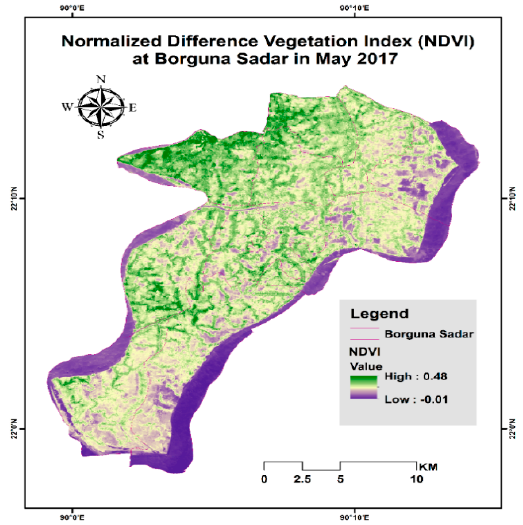
Figure 5 . Normalized Difference Vegetation Index (NDVI) map . Figure 5. Normalized Difference Vegetation Index (NDVI) map.